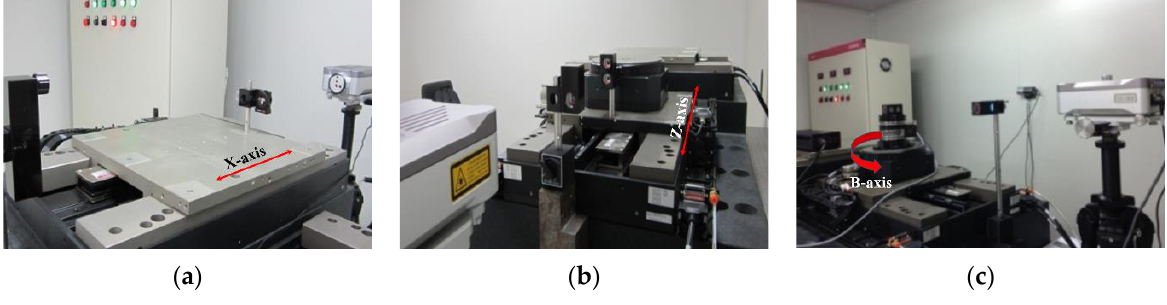
Figure 8. Measuring process. ( a ) Measuring process for the Z − axis. ( b ) Measuring process for the X − axis. ( c ) Measuring process for the B − axis.